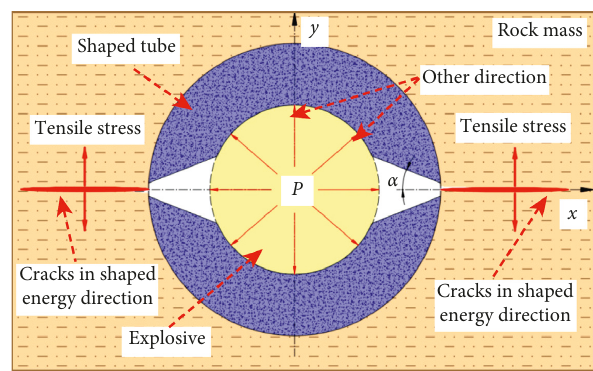
Figure 4: Schematic diagram of the bidirectional cumulative tension blasting principle.